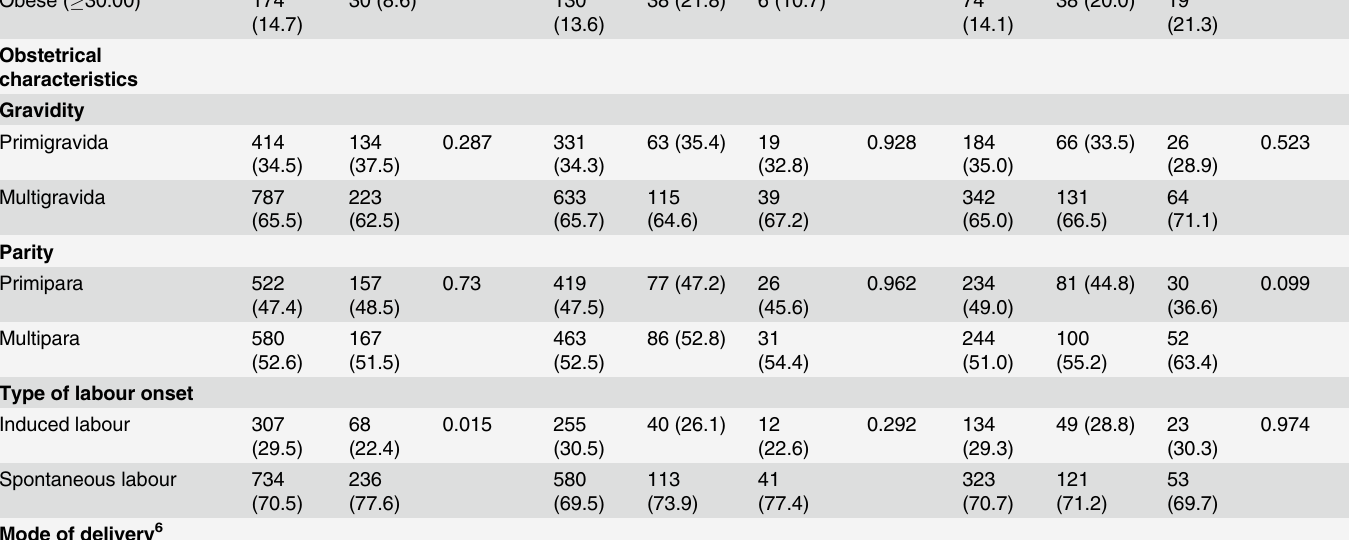
Normal weight (18.50 –